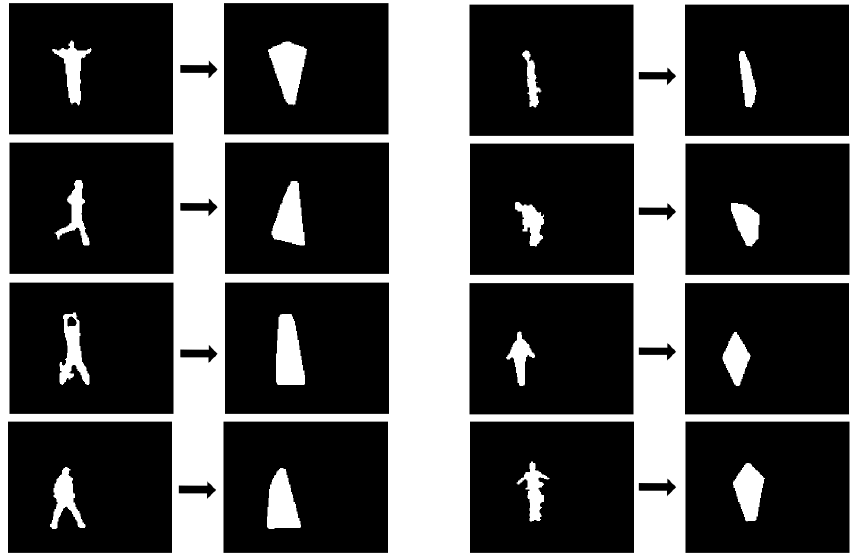
Figure 1. Sample silhouettes from the Weizmann database [30] and the corresponding convex